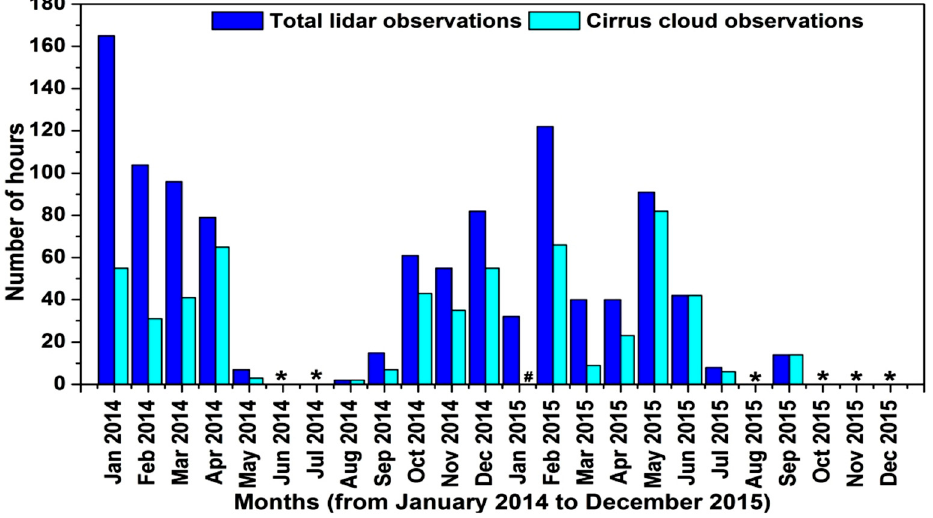
Figure 7. Availability of total lidar observations and cirrus lidar observations. The * denotes no lidar observations, and # represents no cirrus observations.